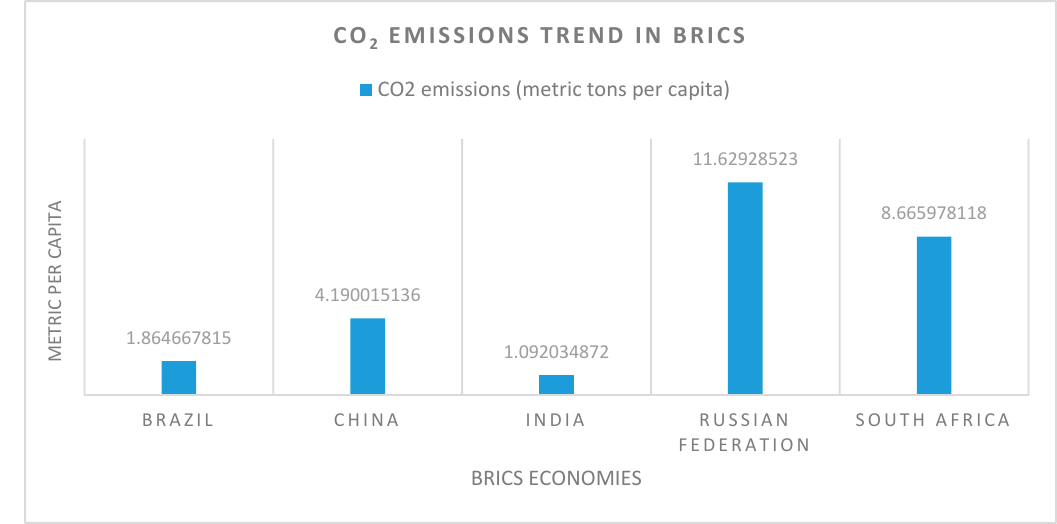
Figure 1. CO 2 emission snapshot of BRICS [27].